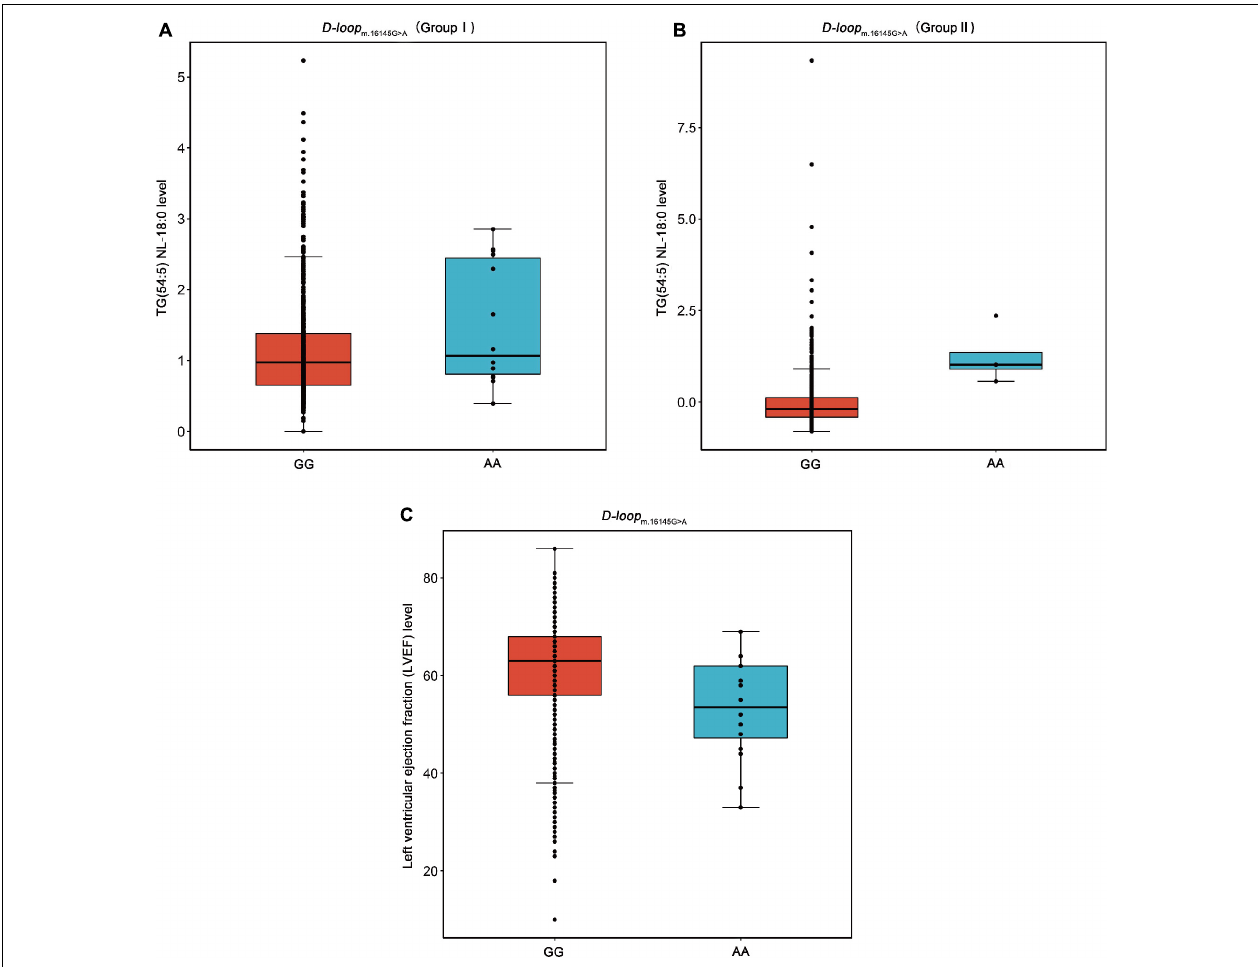
FIGURE 4 | Box plots for the SNP m.16145G > A against the levels of TG(54:5) NL-18:0 and LVEF. TG, triacylglycerol; LVEF, left ventricular ejection fraction. (A) The SNP m.16145G > A (G > A) in D-loop against the level of TG(54:5) NL-18:0 in the Group I. (B) The SNP m.16145G > A (G > A) in D-loop against the level of TG(54:5) NL-18:0 in the Group II. (C) The SNP m.16145G > A (G > A) in D-loop against the level of